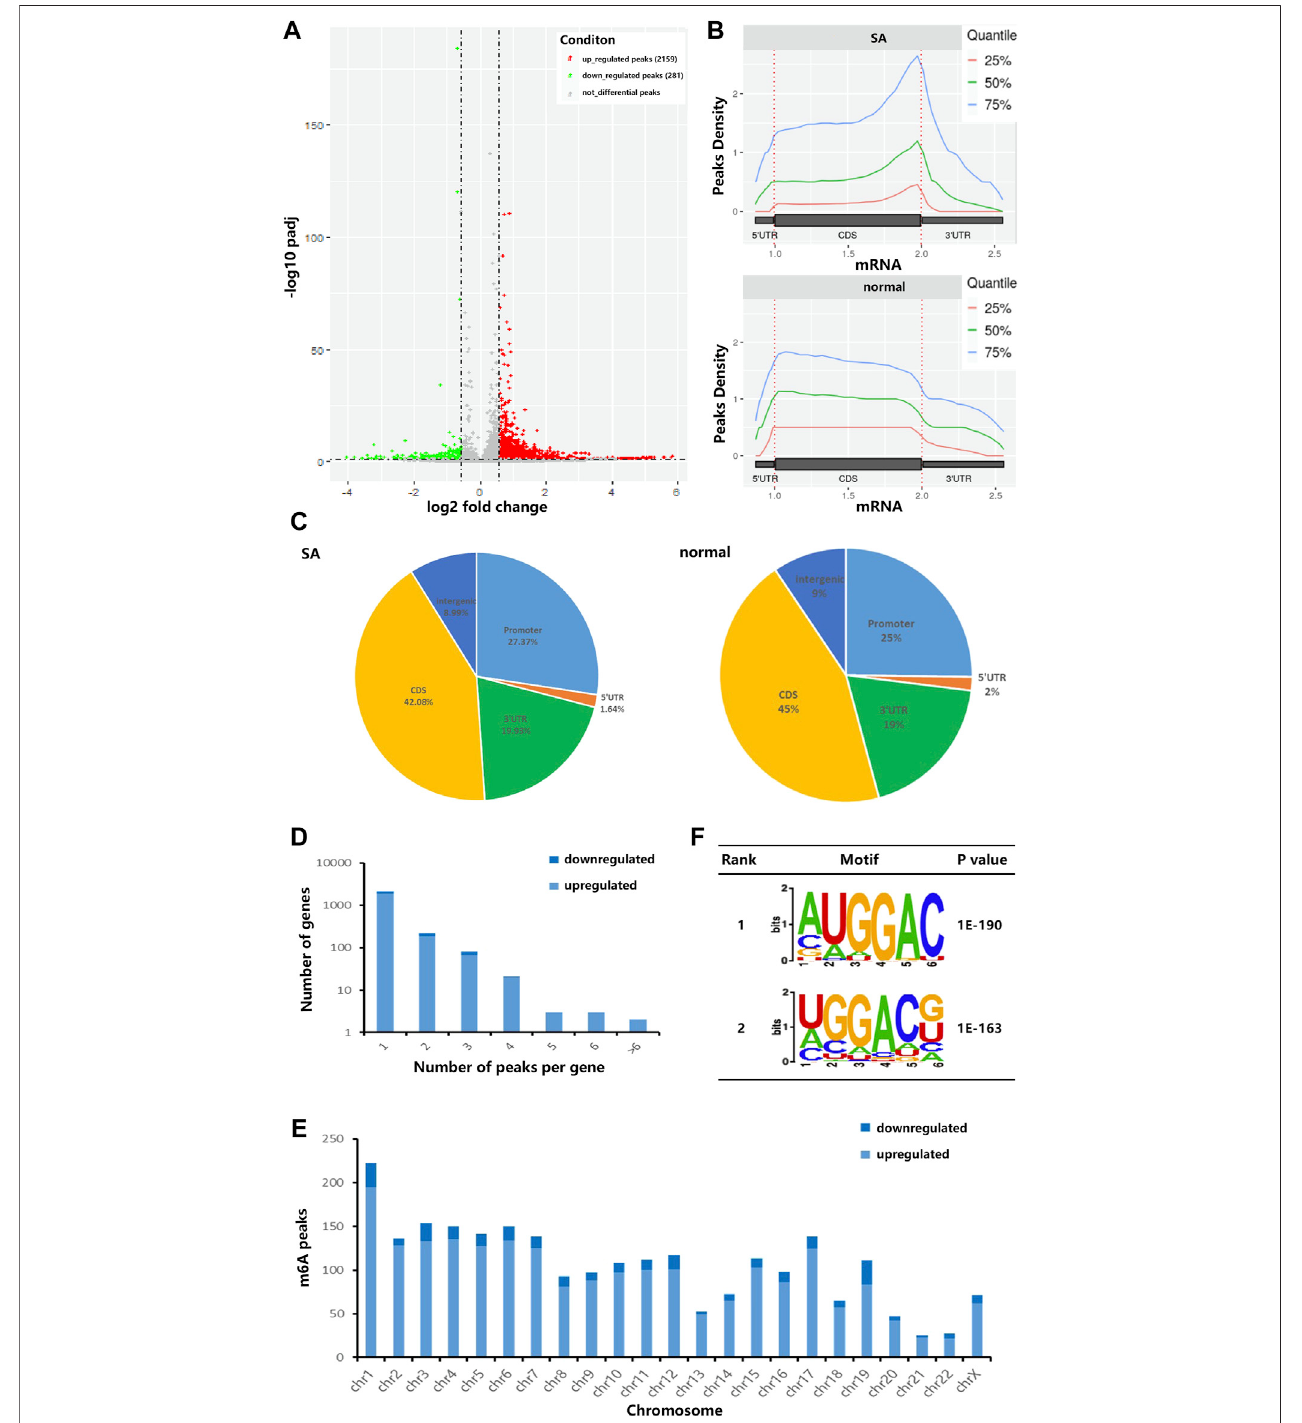
FIGURE 1 | Characteristics of m 6 A methylation in human villi during spontaneous abortion in the fi rst trimester. (A) Volcano plots showing the signi fi cantly altered m 6 Apeaks. (B) Accumulationoftheregionofaveragem 6 Apeaks alongwithalltranscriptsinSAgroupand normalgroup. (C) Piechartsshowing thedistribution ofm 6 A peaks inSAgroupand normal group. (D) Thedistributionofaltered m 6 Apeaks pergene. (E) Thedistributionsofaltered m 6 Apeaks inallchromosomes. (F) Thetoptwo m 6 A motifs enriched from the altered m 6 A peaks.